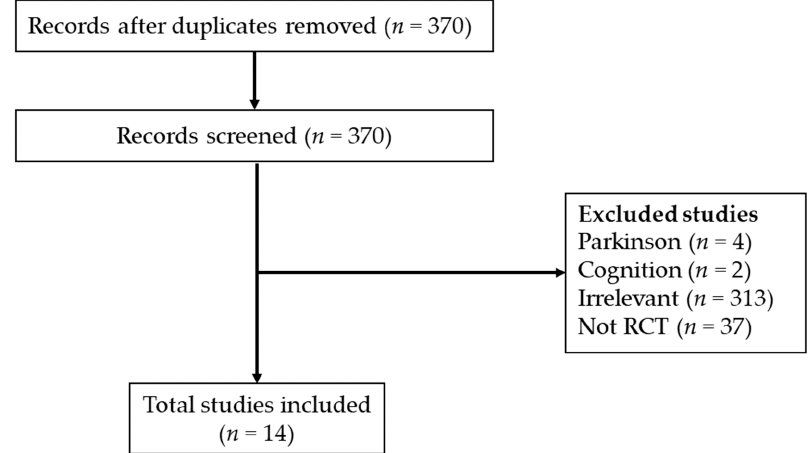
Figure 1. Flow chart displaying the screening process for studies included in this systematic review.